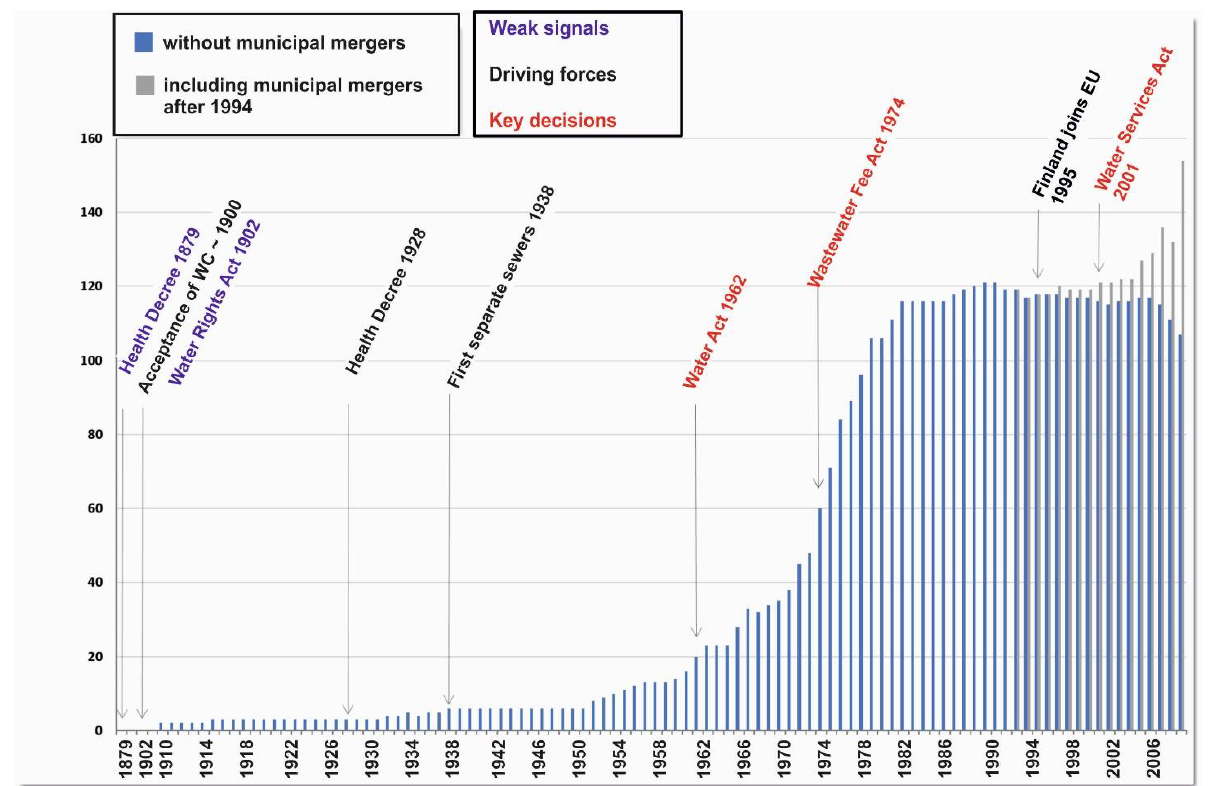
Figure 5. Total number of urban wastewater treatment plants in 1910 – 2009, number located in the 102 cities in existence in 1994 and those including municipal mergers since 1994, with related key legislation ([29], p. 105; modified).